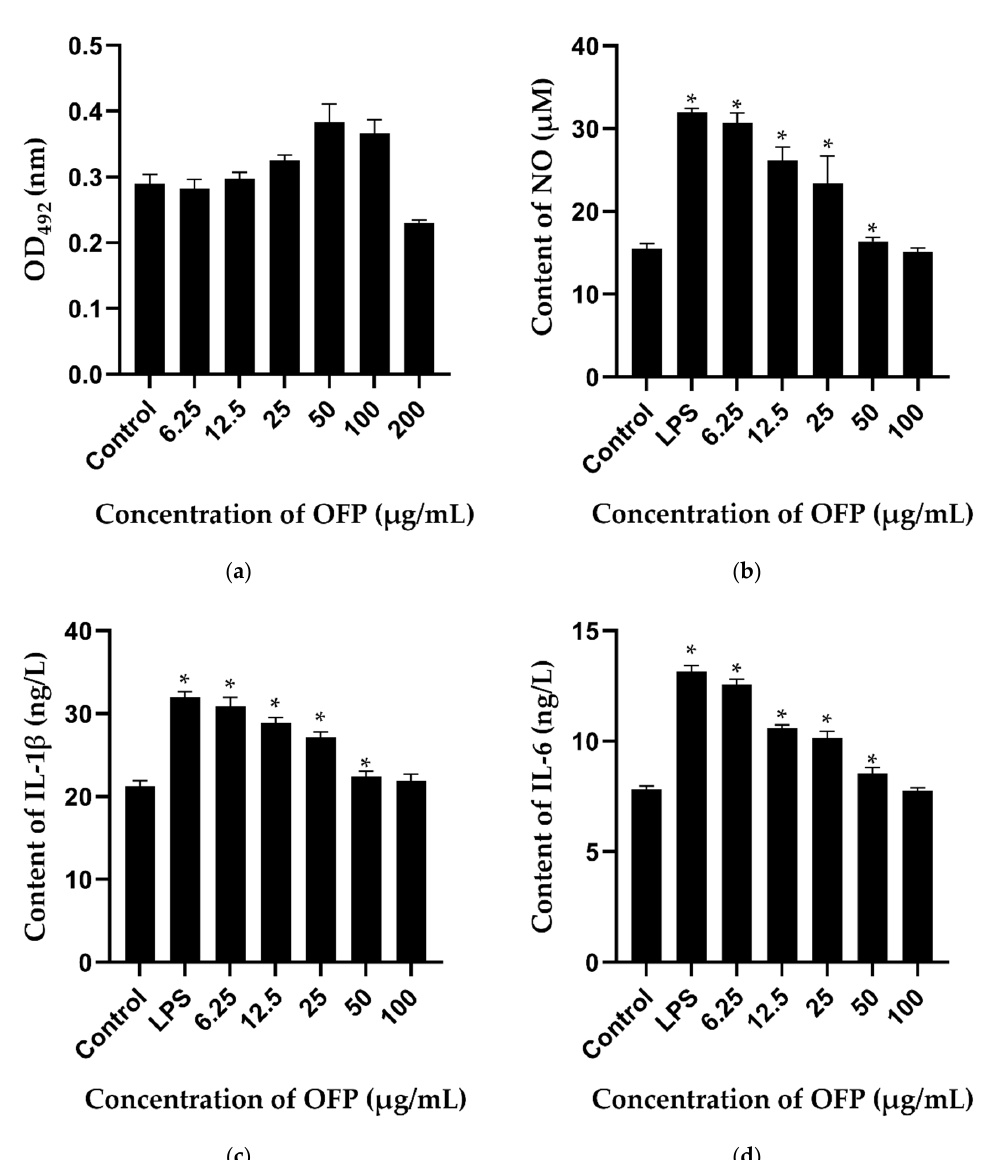
Figure 7. Effect of OFP on the viability of RAW264.7 cells and production of pro-inflammatory factors. Effect of OFP on ( a ) RAW264.7 cell proliferation, ( b ) NO production, ( c ) IL-1 β production, and ( d ) IL-6 production. * p < 0.05, as compared with the control group.